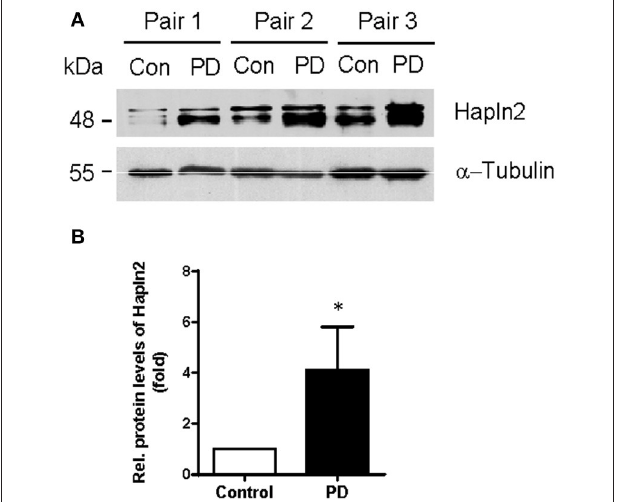
FIGURE 2 | Expression of Hapln2 protein is up-regulated in the substantia nigra of patients with PD. (A) Western blotting of Hapln2 in the SN of PD patients and healthy controls. (B) Quantitative data shown in (A) . Levels of Hapln2 were normalized to actin levels. Data are expressed as mean ± S.E.M. ( n = 3). * P < 0.05 compared to